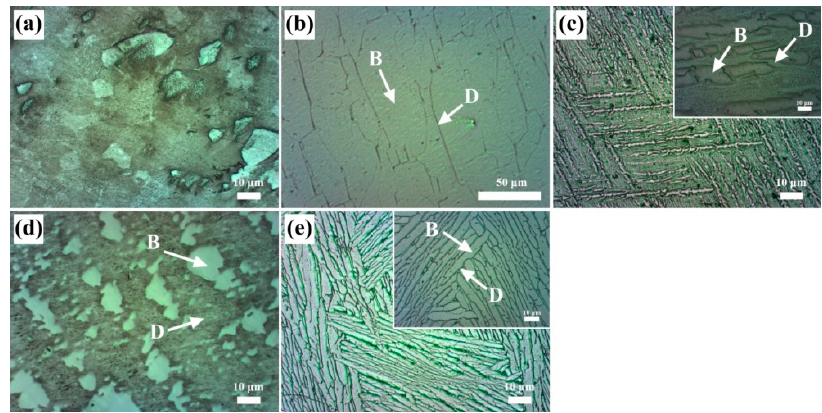
Figure 3. Optical microstructures of ( a ) cp-Ti; ( b ) Ti-5Al; ( c ) Ti-5Cr; ( d ) Ti-5Sn; ( e ) Ti-5V alloys. The micrographs of ( a – e ) are acquired with ×100 and ×200 objective, respectively. The insert images of ( c , e ) are the higher magnification (×200). The marked ‘B’ and ‘D’ mean the bright area and the dark area, respectively. Table 1. The elemental weight percentages of Ti alloys shown in Figure 3.